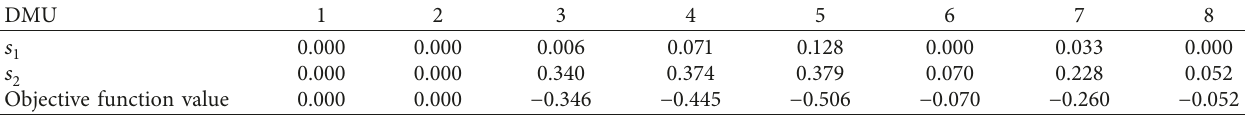
and s calculated by the model ( D ) . 1 2